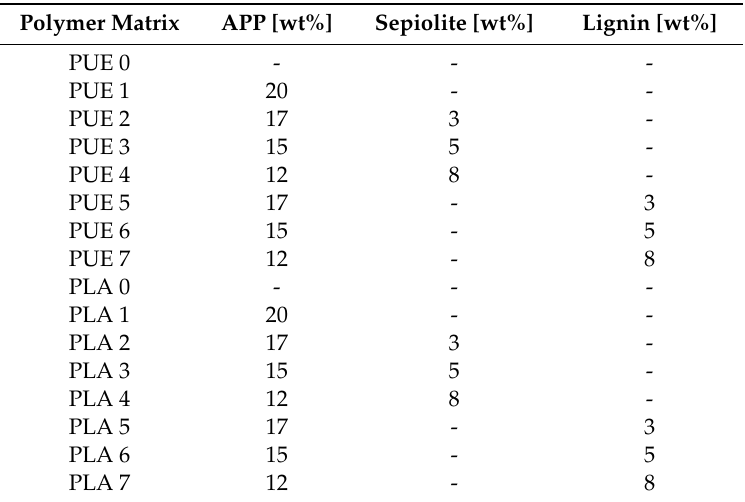
Table 1. List of